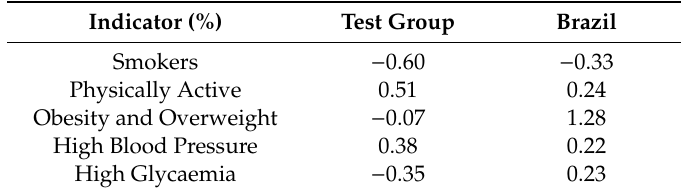
Table 4. Percent variation comparison between the test group and the Brazilian workers (2006–2015).